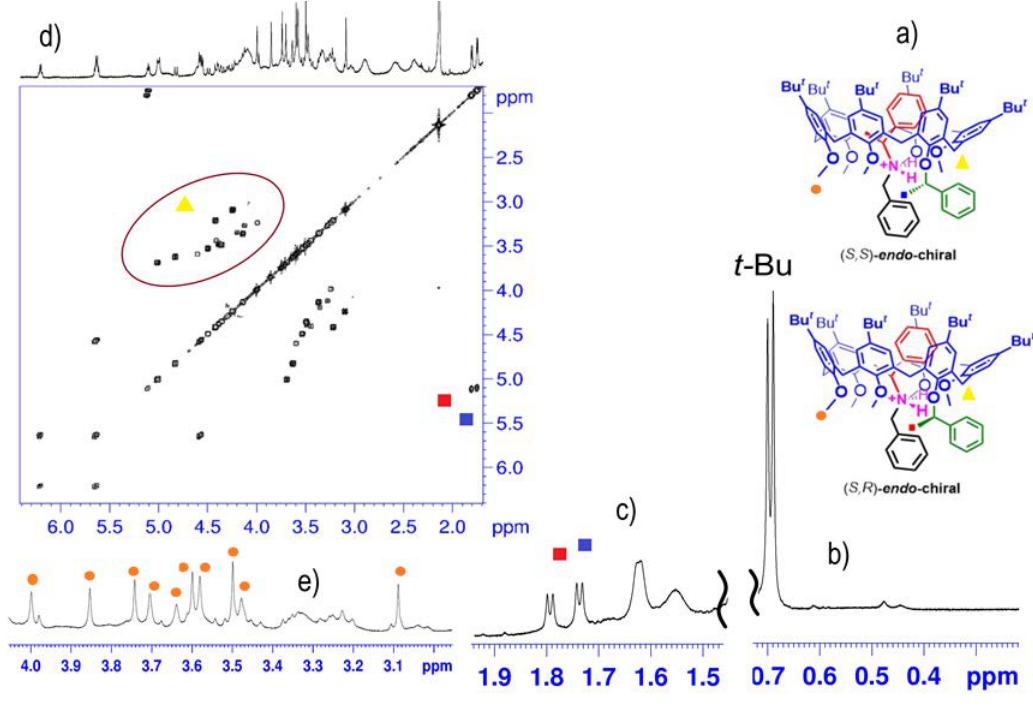
Figure 6. ( a ) Chemical drawing of the two possible endo -chiral ( S )- 9 + @ ( R )- 4 and ( S )- 9 + @ ( S )- 4 pseudorotaxanes. ( b , c , e ) Expansions of the 1 H NMR spectrum (600 MHz, CDCl 3 , 298 K) showing the signals of the two ( S )- 9 + @ ( R )- 4 and ( S )- 9 + @ ( S )- 4 diastereoisomers, in equal ratio. ( d ) Expansion of the COSY spectrum of the 1:1 mixture (3 mM) of ( R / S )- 4 and ( S )- 9 + · B(Ar F ) 4 − , marked the 12 2 J -correlations attributable to the methylene groups of the two